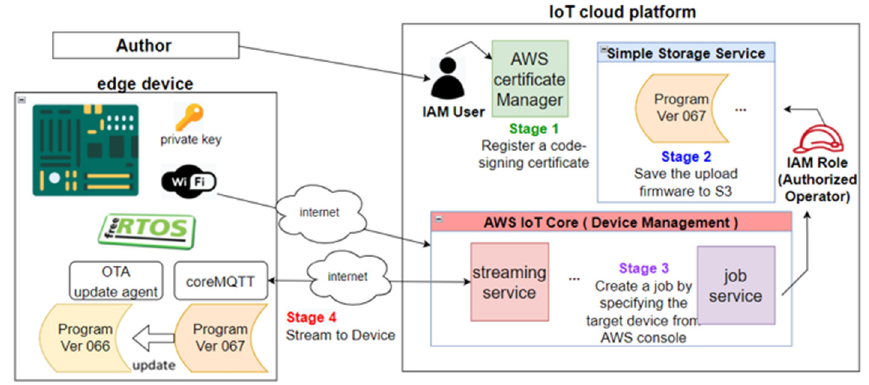
Figure 2. An IoT device OTA architecture by AWS.